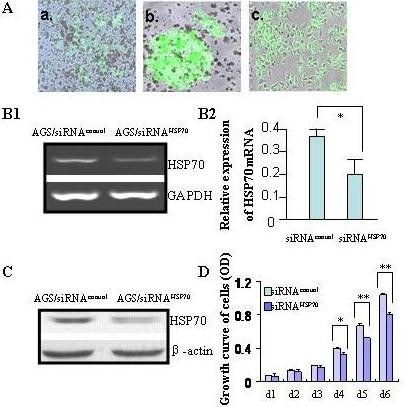
Stable inhibition of HSP70 in AGS cell line by siRNA. (A) AGS cells were transfected with siRNA vector targeting HSP70. a. transient transfection; b. mono-clone cell; c. stable transfection. (B) The level of HSP70 mRNA was measured by real-time PCR. Left panel showed the representative images of PCR in AGS cells transfected with siRNA/HSP70 or empty vector. Quantitative results of real-time PCR were shown in the right panel. GAPDH was used as loading control. (C) The expression profile of HSP70 in transfected AGS cells was further confirmed by immunoblotting with β-actin as an internal control. (D) Suppression of HSP70 by siRNA has inhibited AGS cell growth. Data are mean ± SD, *P <0.05, **P <0.01.